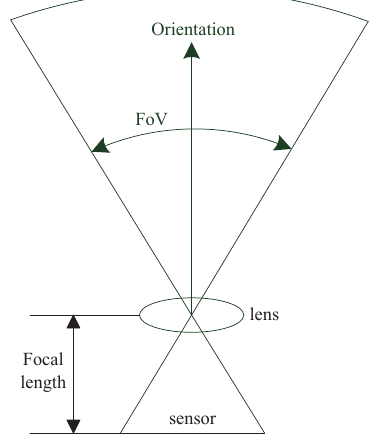
Figure 4. Field of View of A Camera